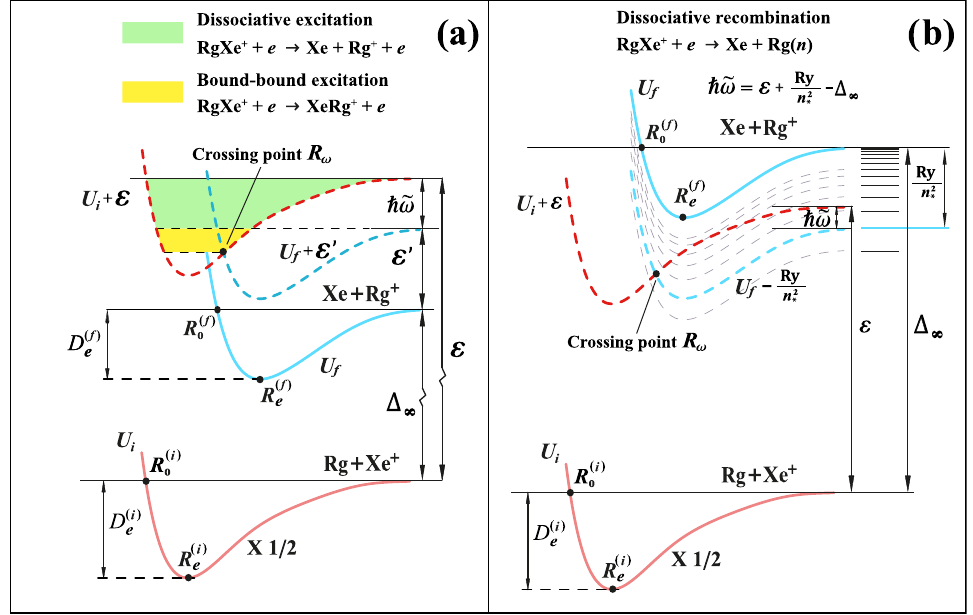
Figure 1. Schematics of the non-adiabatic transitions in RgXe + + e system responsible for processes considered in the present work. ( a ) Dissociative excitation and electron-impact bound–bound excita- tion to charge transfer terms. ( b ) Dissociative recombination via transitions to charge transfer terms. Solid red and light-blue lines denote the initial, U i ( R ) , and final, U f ( R ) , electronic terms of ( RgXe ) + ion. Dashed red and blue lines denote the effective electronic terms, U i ( R ) + ε and U f ( R ) + ε (cid:48) , of the RgXe + + e system in the initial and final states, respectively. Gray dashed lines depict the effective molecular Rydberg states, U f ( R ) − Ry / n 2 ∗ , of the Rg ∗ Xe molecule converging to a CT-type excited term of RgXe +